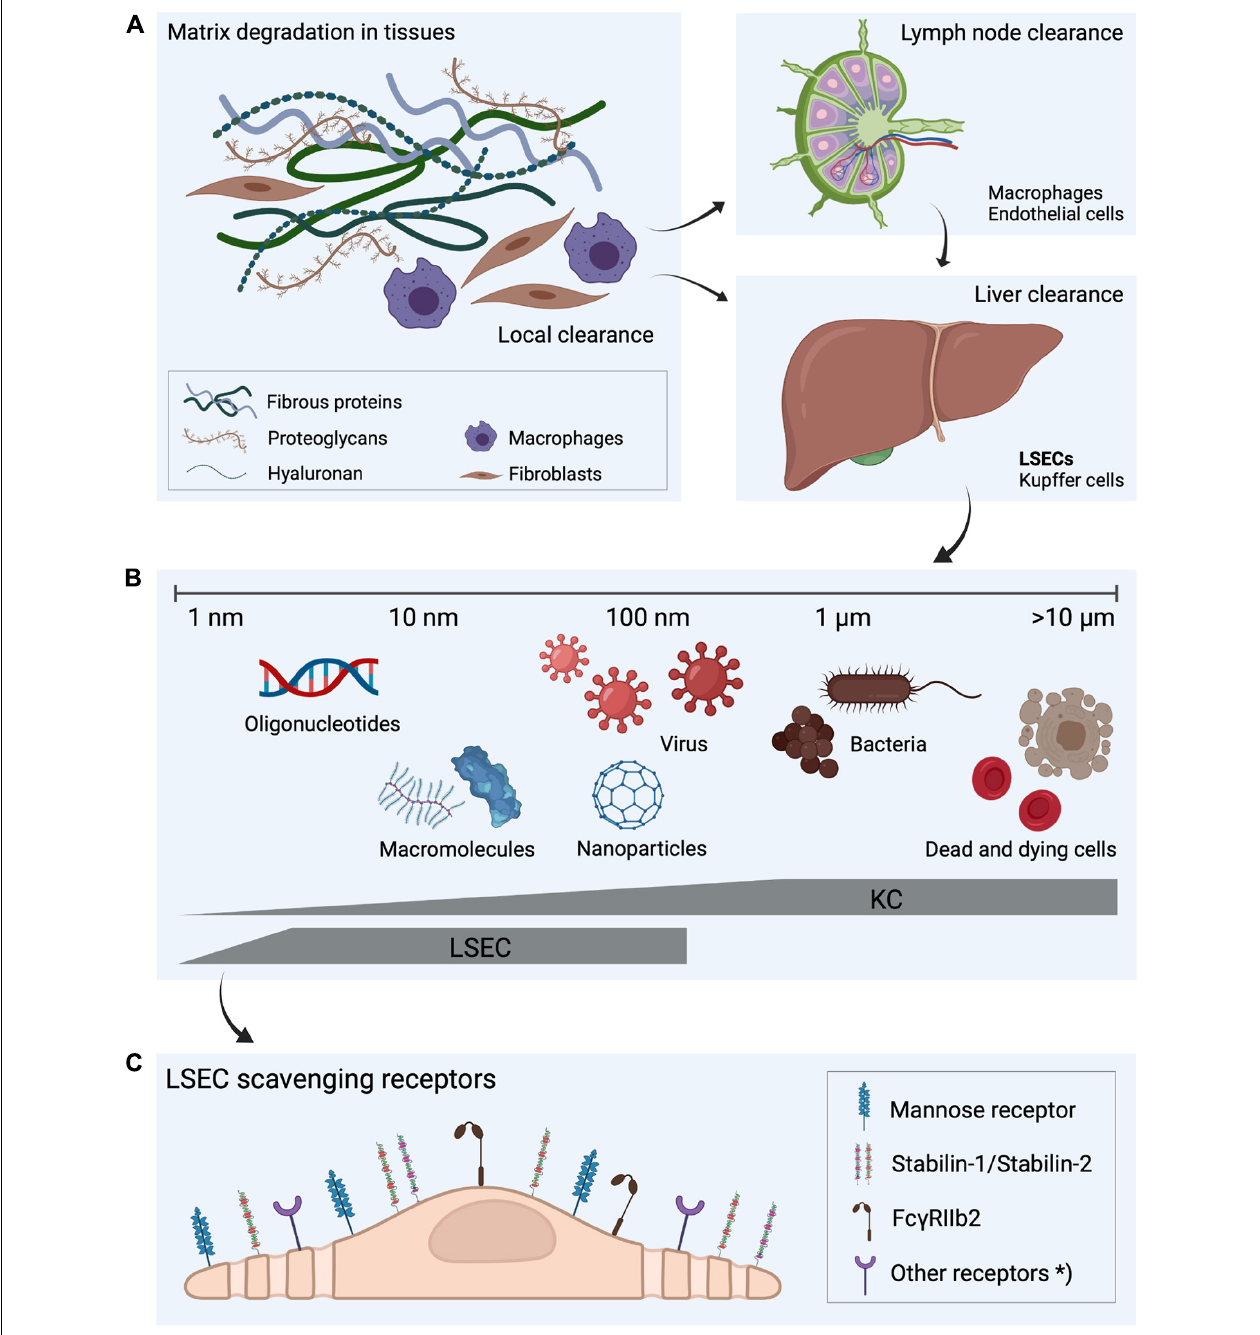
FIGURE 1 | Fate of extracellular matrix turnover products, the dual cell principle of waste clearance and the role of liver scavenger cells in waste clearance. (A) Molecular fragments are continuously released during the constant turnover of the extracellular matrix. Some of the degradation products are digested locally but a large proportion is drained to lymph nodes where they are endocytosed by macrophages and sinusoidal endothelial cells (Laurent et al., 1986a; Fraser et al., 1997). The fragments that escape uptake in lymph node cells leak to the blood circulation (Østgaard et al., 1995), and are removed from blood by endocytosis in liver scavenger cells. (B) Liver sinusoidal endothelial cells (LSECs) and Kupffer cells, which together make up the largest population of scavenger cells in the body, share the scavenging workload in the liver (Seternes et al., 2002). LSECs are specialized on effective clathrin-mediated endocytosis of soluble macromolecules and nanoparticles, whereas larger particles, such as bacteria and dead and dying cells are cleared by the Kupffer cells, illustrating “the dual cell principle of waste clearance” (Sørensen et al., 2012). (C) The uptake of soluble macromolecules in LSECs are mediated by a range of endocytic receptors, with the mannose receptor, stabilin-1, stabilin-2, and Fc γ RIIb2 being the most investigated. *Other endocytic receptors may also contribute to the effective waste clearance performed by LSECs. Figure created with BioRender.com.